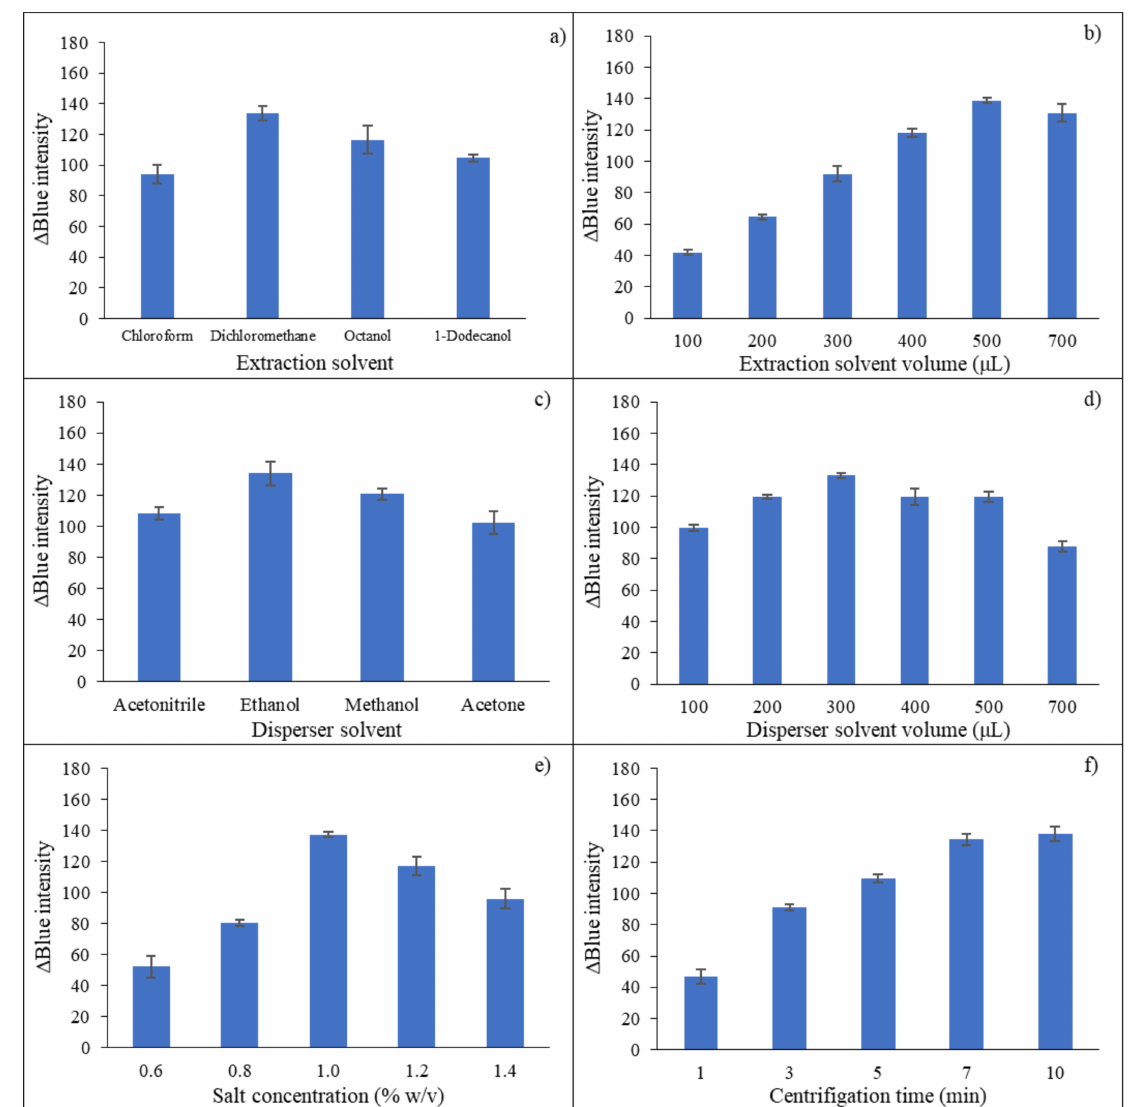
Figure 3. Investigation of DLLME parameters on carbaryl detection using smartphone-based digital image analysis; ( a ) effect of extraction solvent type; ( b ) effect of extraction solvent volume; ( c ) effect of dispersive solvent type; ( d ) effect of dispersive solvent volume; ( e ) effect of salt concentration and ( f ) effect of vortex time on the sensitivity of carbaryl